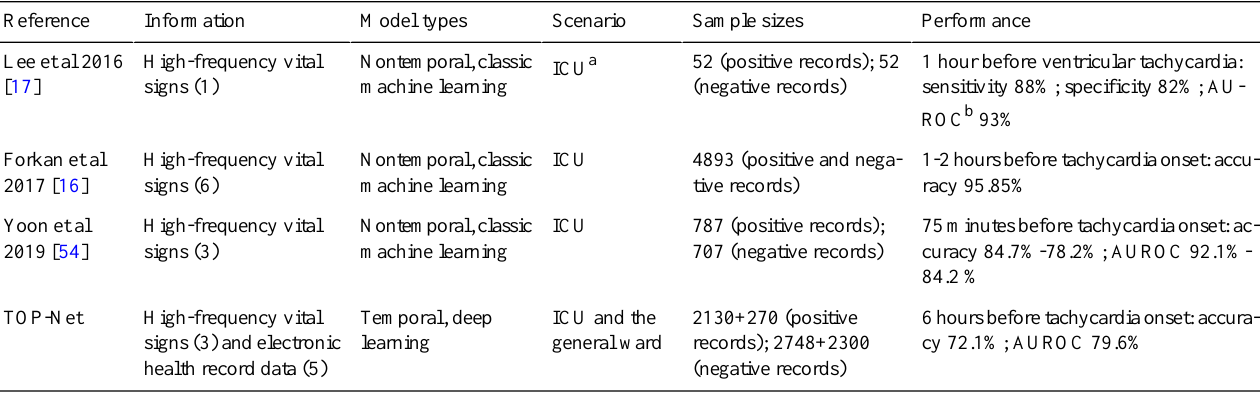
Table 6. Review of the performance of related algorithms.